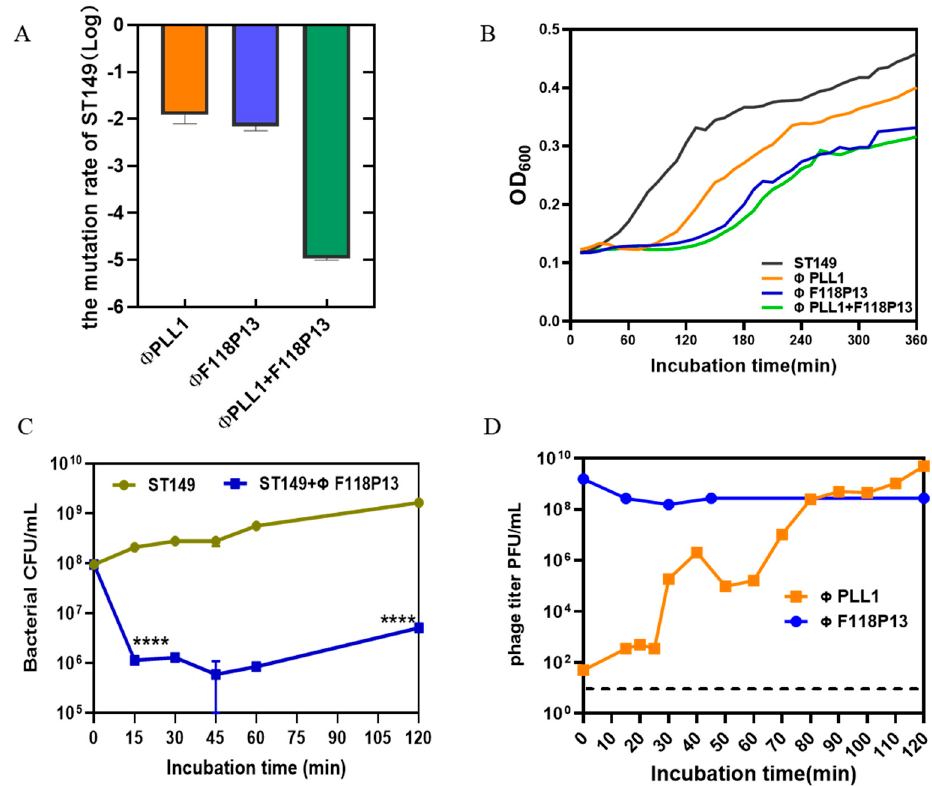
Figure 2. Comparison of the lytic activity of the phage combination and single phage alone on S. Typhimurium strain ST149 in vitro. ( A ) Mutation rates of ST149 resistance to phages. ( B ) Phages’ lytic activity on ST19 in vitro. Approximately 10 8 Salmonella cells alone, or cells mixed with single phage or phage combination (MOI = 1) were incubated aerobically at 37 ◦ C in 96-well plates. OD 600 was measured at 10 min intervals for 6 h. ( C ) Φ F118P13’s lytic ability on ST149. Approximately 10 8 Salmonella cells alone, or cells mixed with phages (MOI = 10) were incubated aerobically at 37 °C. Bacterial cells were determined by plating on LB plates. ( D ) The growth curve of Φ PLL1 and Φ F118P13’s proliferation in ST149. Approximately stationary phase 10 8 CFU/mL of bacterial cells were incubated with Φ PLL1 and Φ F118P13 in LB medium at an MOI of 0.01 and 10, respectively. Phage titer was determined by plating on double-layer agar plates. **** p < 0.0001 (Student’s t -test).